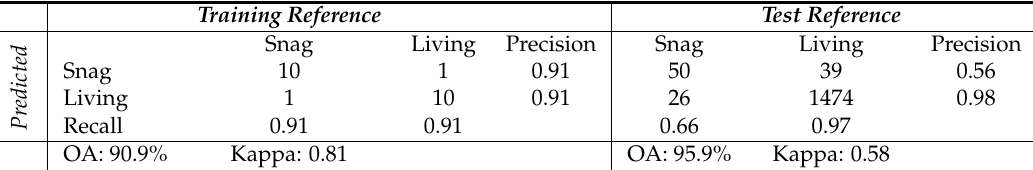
Table 16. Results of the classification of snags for both parks. Labelled data are from areas A 1, A 2, and A 3. 55 snags and 524 living trees for training. 76 snags and 1513 living trees for testing. Confusion matrices for training (left): Number of living are reduced to the number of snags. Numbers refer to the average of the five test sets of the five-fold cross-validation. Tree segments are classified as snags if the threshold for class probability p snag >